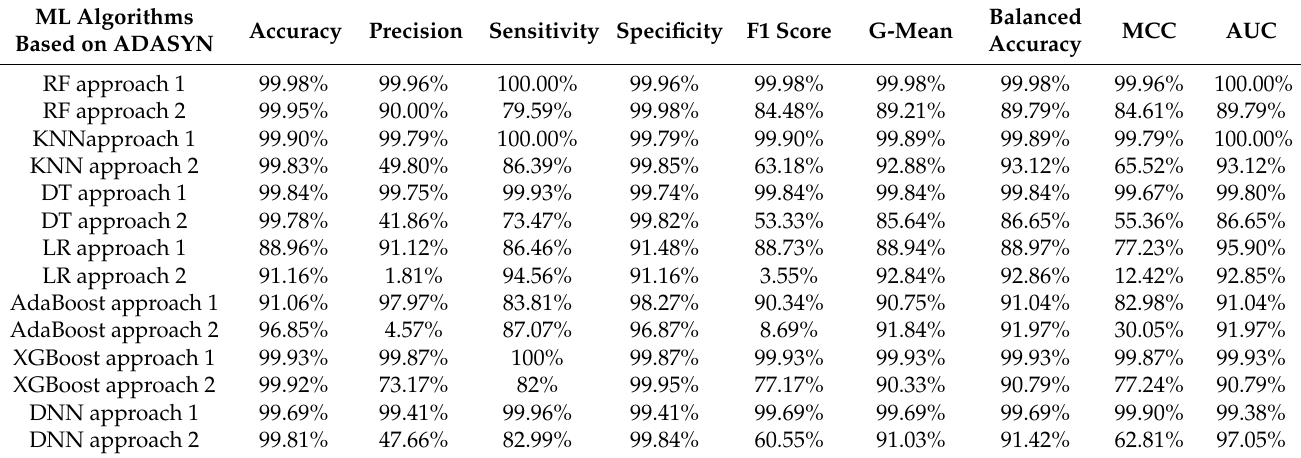
Table 14. Classification measurements indexes of ML algorithms based on ADASYN for two resampling approaches. ML Algorithms